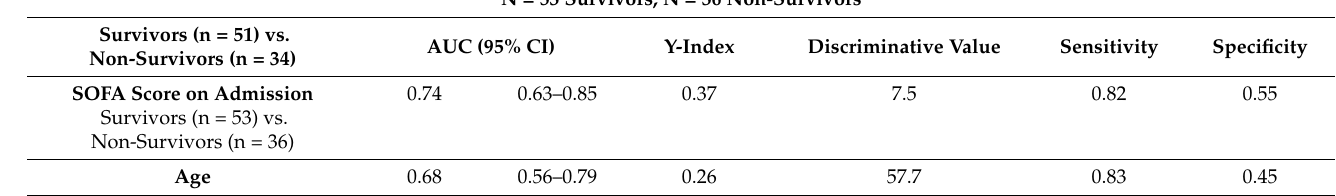
Table 3. ROC analysis for the prediction of mortality with Youden index, sensitivity and specificity. AUC, area under the curve; CI, confidence interval; Y-index; Youden index; and SOFA, sequential organ failure assessment score.